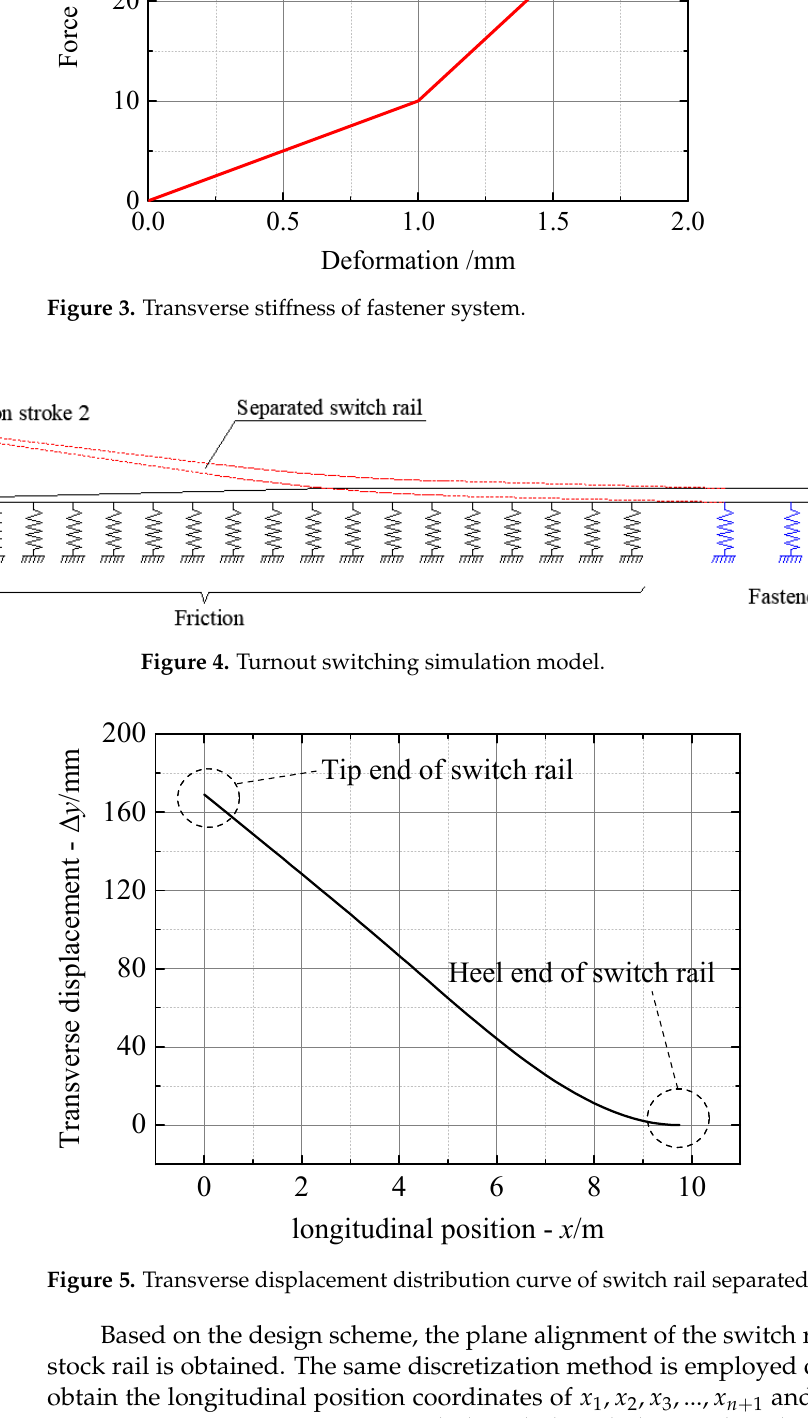
Figure 3. Transverse stiffness of fastener system.